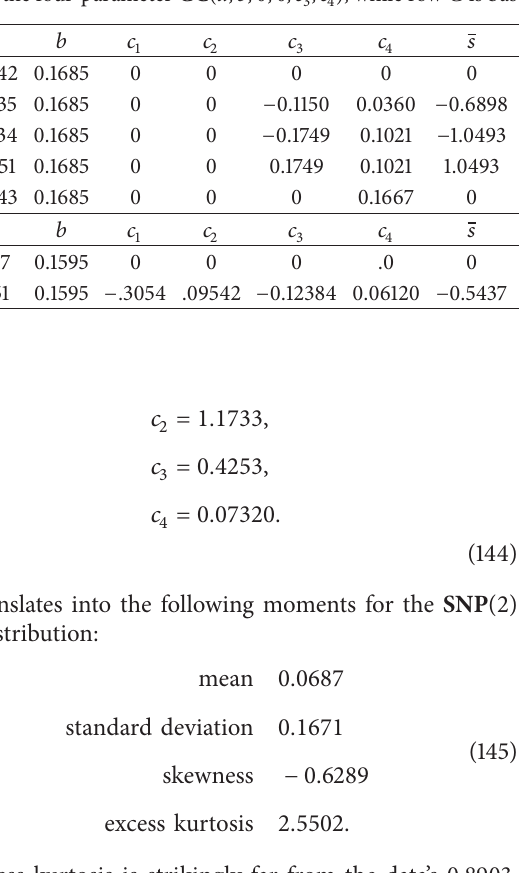
Table 1: Comparison of ratchet option values computed with the Black-Scholes formula and Gram-Charlier distributions. Rows A to F are based on the four-parameter GC (𝑎, 𝑏; 0, 0, 𝑐 3 ,𝑐 4 ) , while row G is based on a six-parameter GC (𝑎, 𝑏; 𝑐 1 ,𝑐 2 ,𝑐 3 ,𝑐 4 ) .